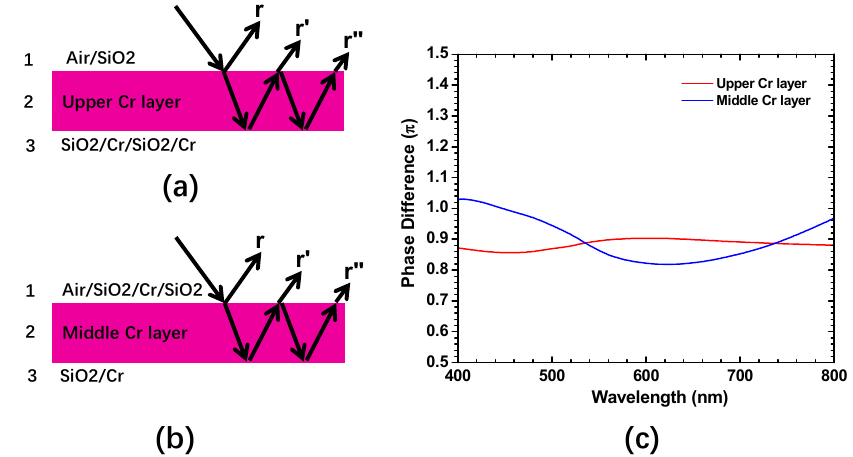
Figure 5. ( a ) Effective upper Cr layer diagram for six-layer structures; ( b ) effective middle Cr layer diagram for six-layer structures; ( c ) the calculated reflection phase difference on the front surface of both upper and middle Cr layers.